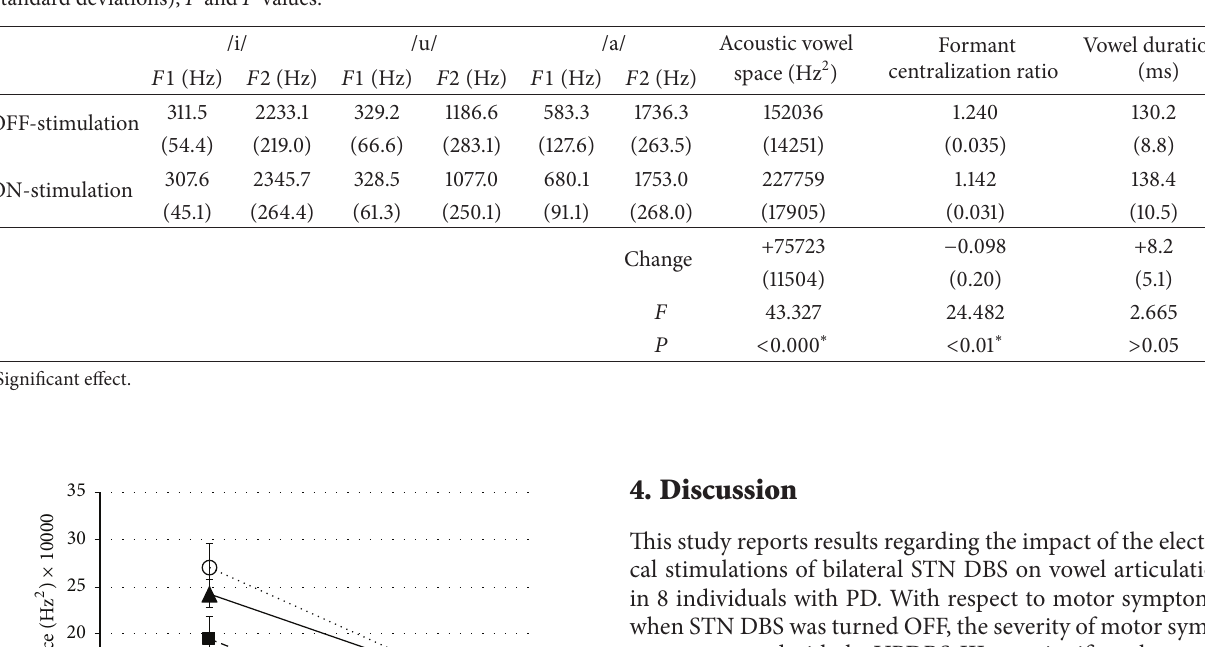
Table 4: Formant frequencies, acoustic vowel space, formant centralization ratio, and vowel duration at OFF- and ON-stimulation: means (standard deviations), 𝐹 and 𝑃 values.